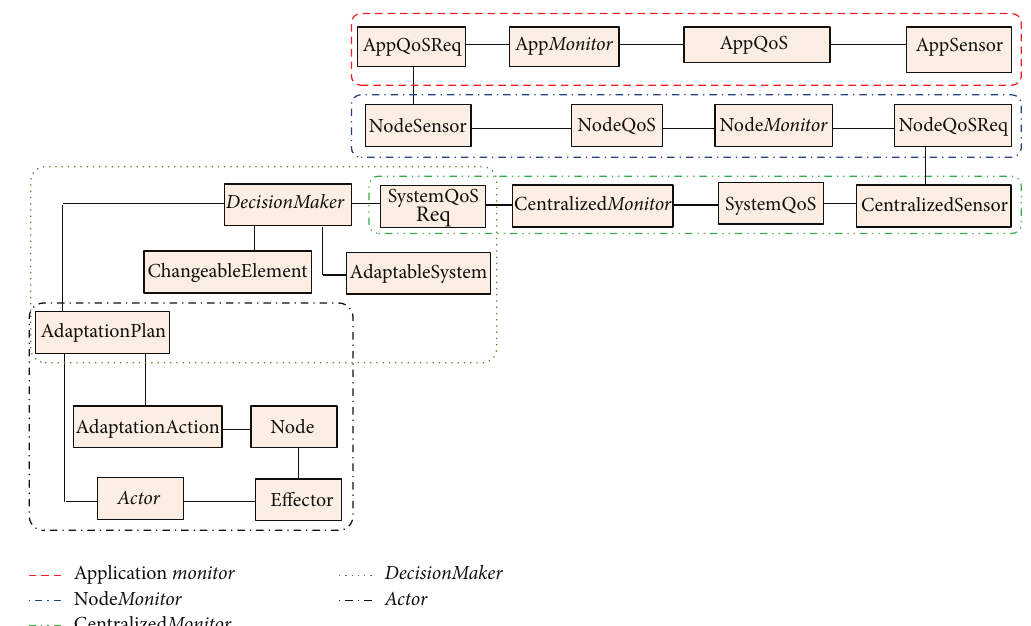
Figure 15: Structure of the RACE’s feedback control loop [44].